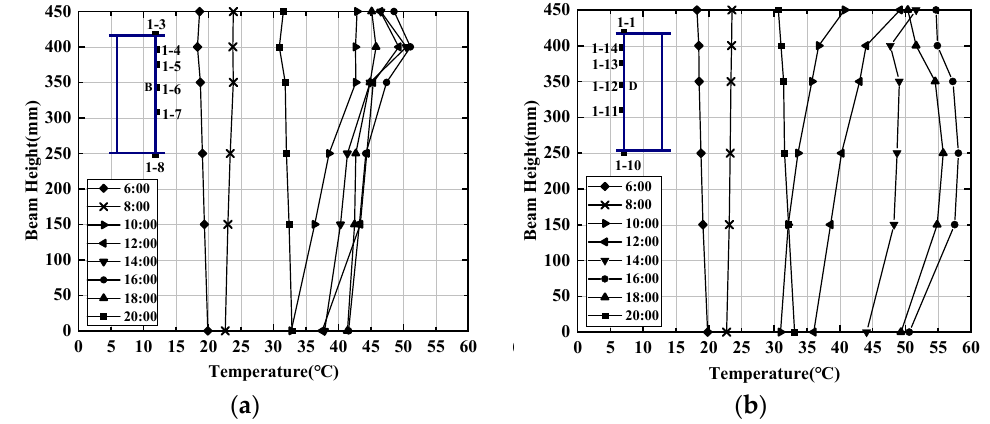
Figure 6. Vertical temperature gradient of the steel box girder at various times (30 July 2021). ( a ) Plate B; ( b ) plate D.